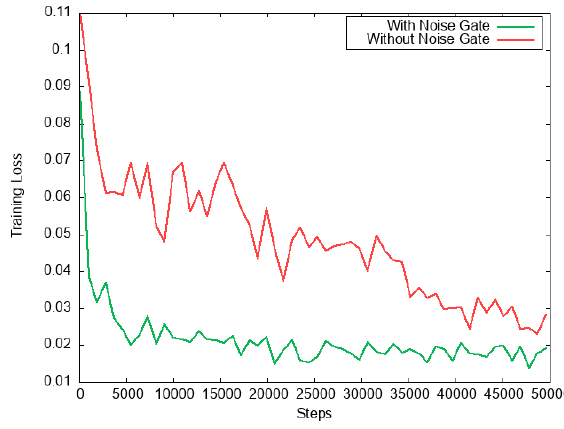
Figure 11. Graph of training loss. It is visible that the noise gate used in DRAB illustrates far more training stability. Also, it helps the proposed method to encounter faster convergence time.